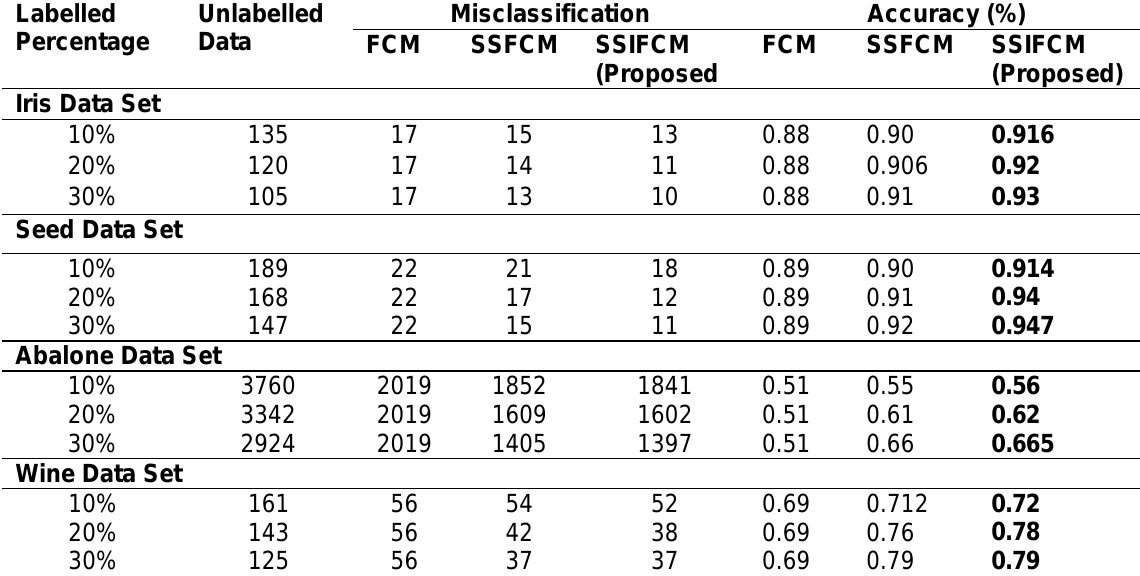
Table 5 . Comparative analysis of SSIFCM algorithm with FCM and SSFCM in terms of number of misclassifications and accuracy.